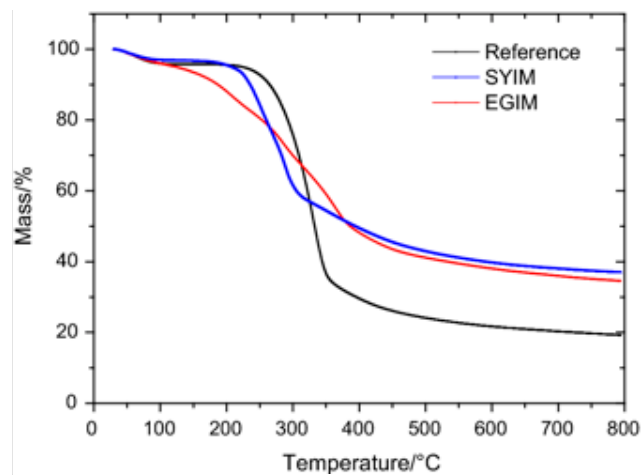
Figure 4. TG (thermogravimetric) curves of synergetic fire retardants insulating material (SYIM) and expandable graphite insulating material (EGIM) [27].